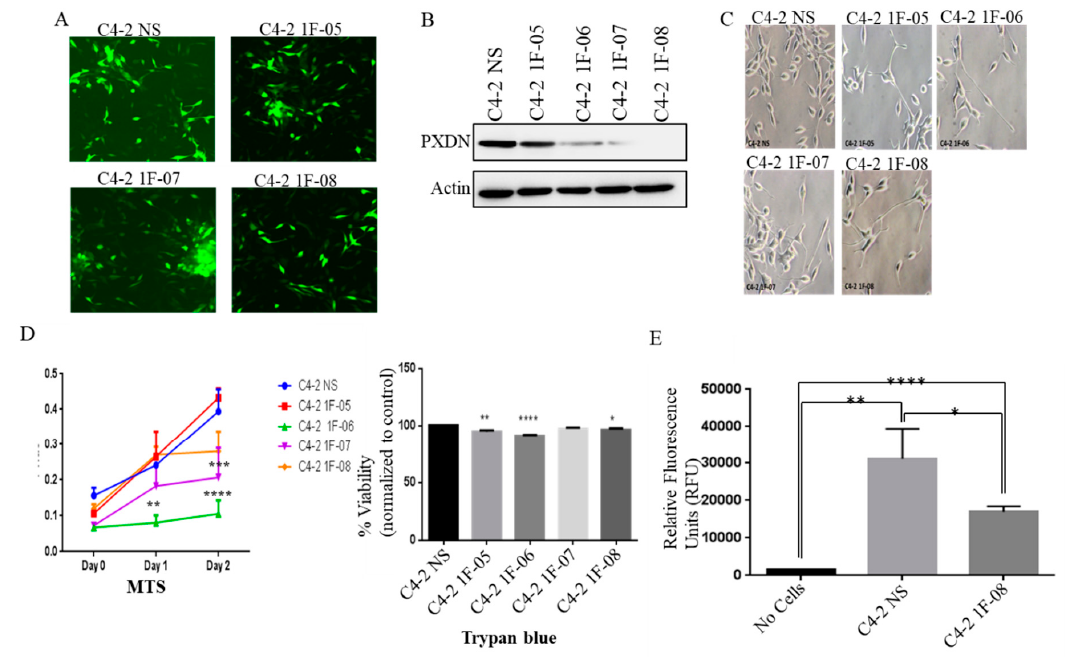
Figure 2. PXDN stable knockdown in C4-2 cells decreases cell viability and growth on soft agar. ( A ) PXDN was stably knocked down in C4-2 prostate cancer cells using 4 different shRNA constructs (1F-05, 1F-06, 1F-07, 1F-08) or non-silencing (NS) construct as a control. ( A ) Fluorescence microscopy (magnification at 20 × ) was used to detect GFP to confirm successful transduction. ( B ) Western blot analysis was performed to confirm successful knockdown of PXDN. Actin was utilized as a loading control. ( C ) Phase contrast microscopy (magnification at 20 × ) shows the morphology of PXDN knockdown cells. ( D ) Cell viability was investigated using MTS or Trypan blue assay. ( E ) Soft agar colony formation was measured in C4-2 NS (control) and representative C4-2 1F-08 (PXDN knockdown) cells. Values were normalized to C4-2 NS and the mean ± SEM of data were obtained from three independent replicate experiments. Statistical analysis was done with GraphPad Prism; (**** p < 0.0001, *** p < 0.001, ** p < 0.01, * p < 0.05).